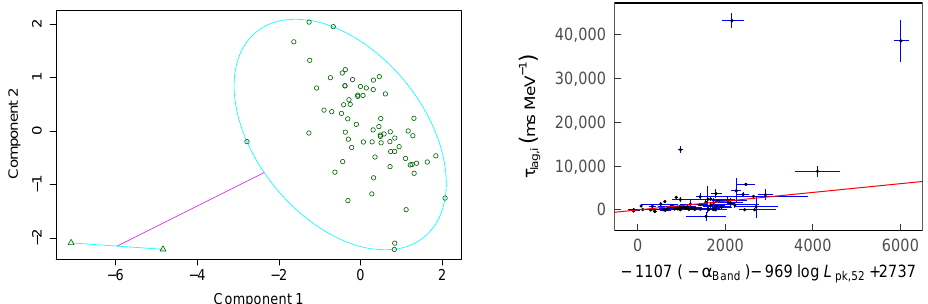
Figure 5. Similar to Figure 1, with the three parameters being τ lag,i , α Band and L pk,52 . The outliers are GRB 980425B and 030528A. The linear regression result is τ lag,i = ( − 1107 + 520 − ( 969 + 150 ) × log L + ( 2737 + 230 ) . The adjusted R 2 is pk,52 − 570 − 150